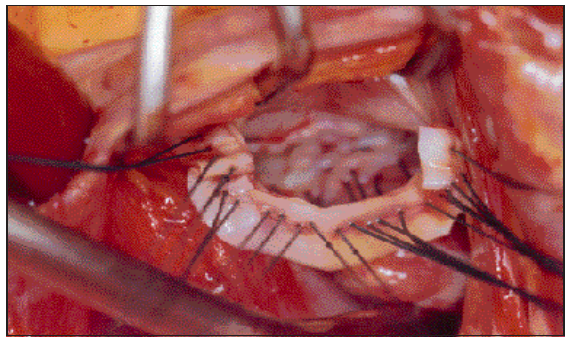
Fig. 6 – Visão cirúrgica. Anuloplastia mitral com retalho de pericárdio